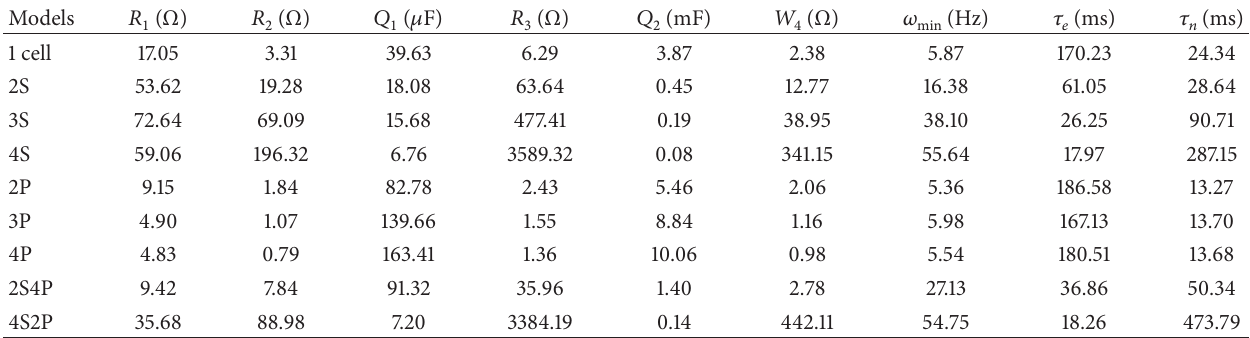
Table 2: Measurement results of EIS based on different DSSC model